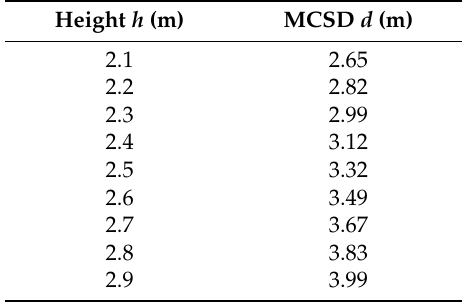
Table 1. The height of the subject and the required minimal camera to subject